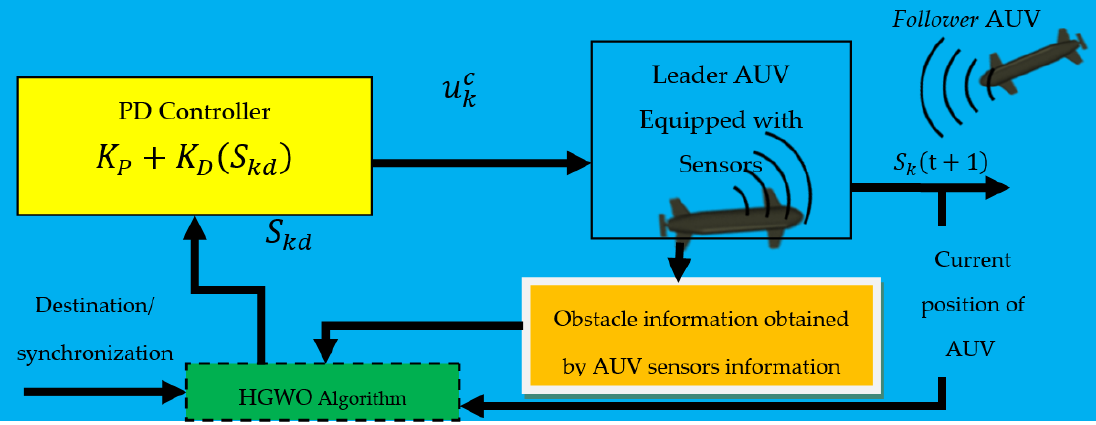
Figure 4. Path planning with HGWO using the PD controller.